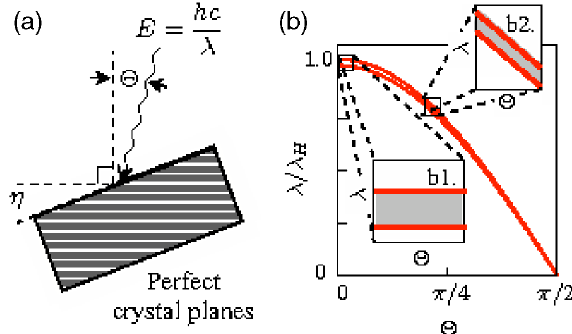
FIG. 1. (a) General Bragg diffraction geometry of x rays from a crystal. The incident radiation makes an angle (cid:1) from the normal to the reflecting atomic planes, which differs from the surface normal by the asymmetry angle (cid:1) . (b) Bragg diffraction occurs in a small band in (cid:2) and (cid:1) near the Bragg condition (cid:2) ¼ (cid:2) H cos(cid:1) . Near backscattering ( (cid:1) (cid:4) 1 ), the reflectivity is nearly independent of (cid:1) as shown by the shaded area in box (b1). For generic incidence angles, the reflectivity range is given by the box